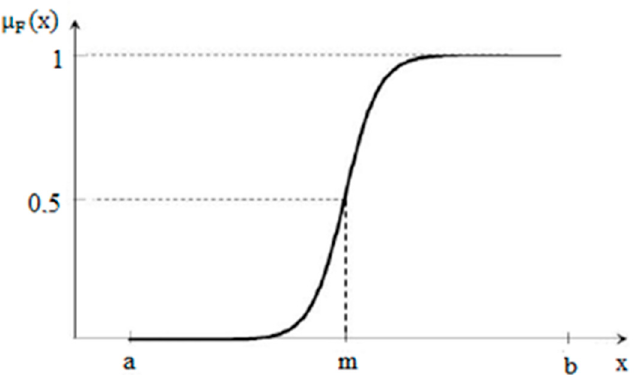
Figure 10. Fuzzy sigmoidal membership function. U is a given set Universe. A fuzzy subset F from U is characterized by a membership function, represented by μ F : U → [0,1], which associates to each x ϵ U , a real number μ F ( x ) defined in the interval [0,1]. This representation allows a gradual transition between the membership ( μ F ( x ) = 1) and the non-membership ( μ F ( x ) = 0) [28].